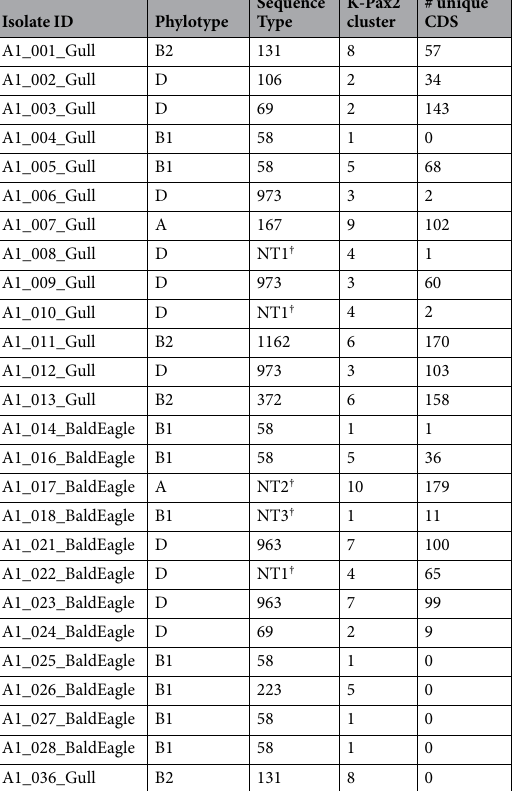
Table 1. Genomic characteristics of 26 cephalosporin-resistant E. coli isolates originating from gull and bald eagle faecal samples in Alaska. † NT = new sequence